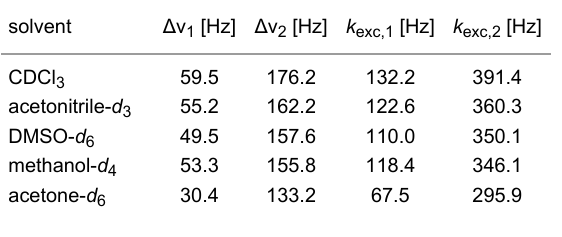
Table 1: NMR parameters Δν and k exc of nitro compound 3a measured in dependence of the